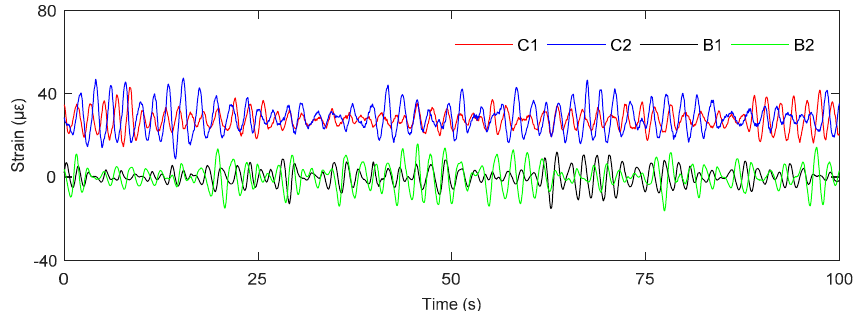
Figure 17. Time-series of the strain response at measurement position S2 in both wave and storm conditions.